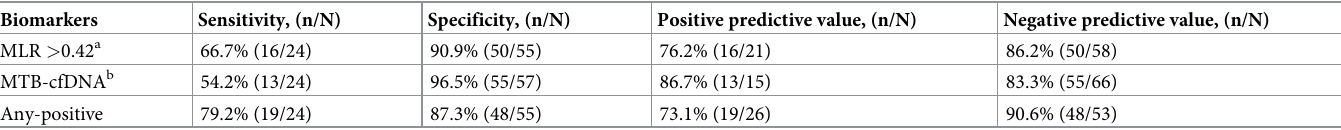
Table 4. Accuracy of MTB-cfDNA positivity and an MLR > 0.42 for detecting PTB.